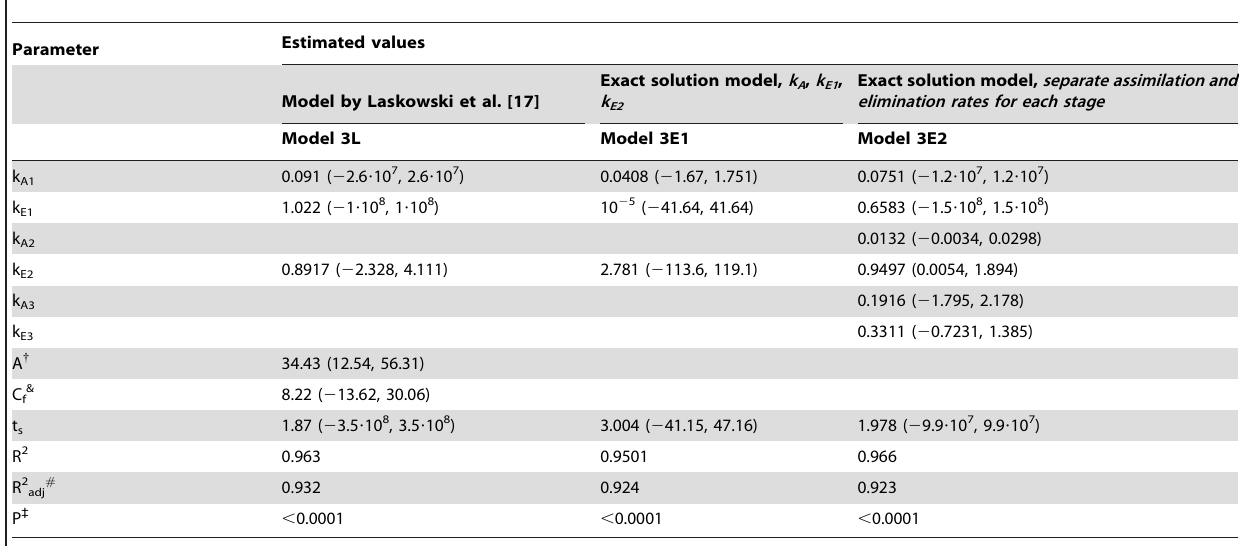
Table 3. Comparison of the three three-stage models of the complex nickel toxicokinetics in Pterostichus oblongopunctatus [17].